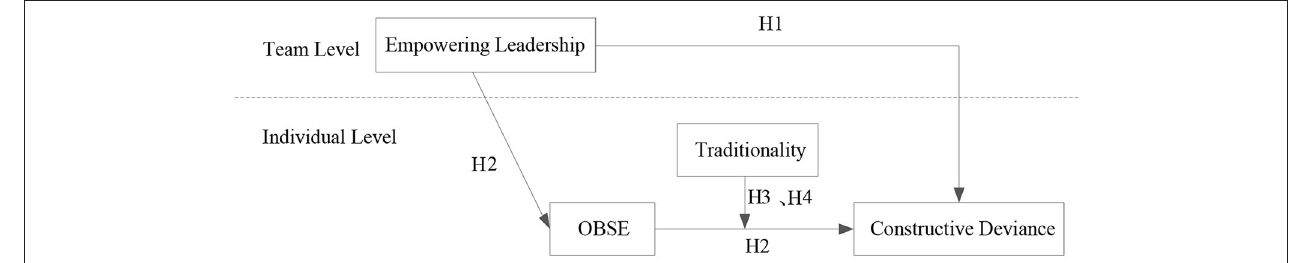
FIGURE 1 | Theoretical